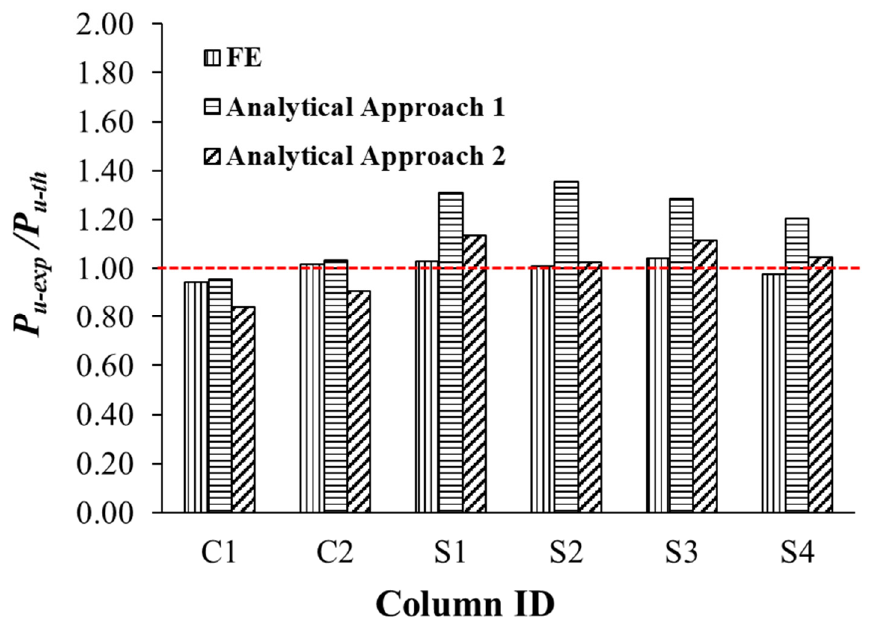
Figure 14. Tested-to-predicted ultimate load ratio for column specimens.